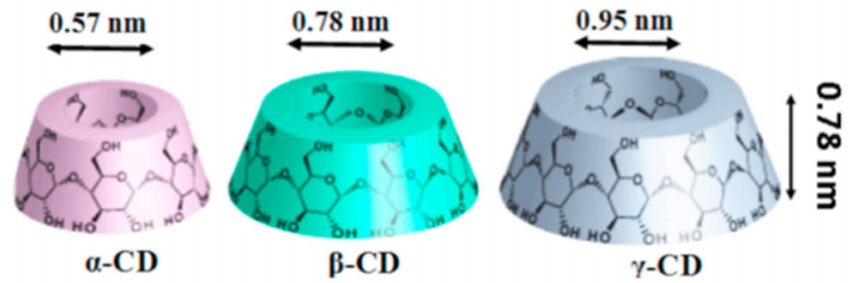
Figure 1. Schematic representations of the native cyclodextrins (CDs) ( α -, β -, and γ -CDs). All three native CDs have a similar depth or height (7.9 Å); however, a key difference lies in their inner diameters, with α -, β - and γ -CDs having inner diameters of 5.7, 7.8, and 9.5 Å, respectively. Images adapted and reproduced from [11]. Copyright 2017 Elsevier